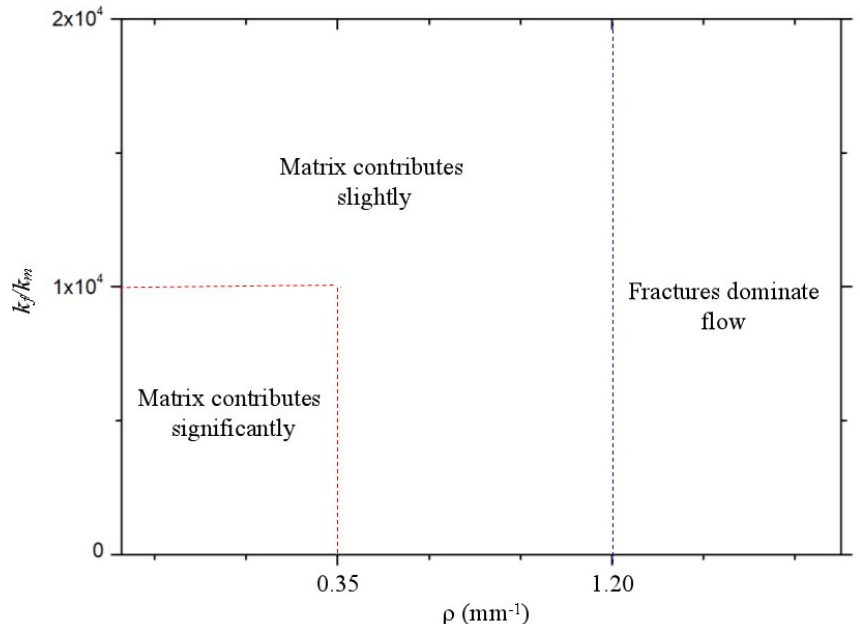
Figure 14. Two-dimensional fluid flow partitioning between the fractures and matrix of fractured rocks with various fracture densities ( w av = 0.284 mm). Three flow regimes were classified to demonstrate fracture–matrix flow partitioning using the permeability ratio k f // k m and fracture density ρ . (i) The matrix significantly contributes to the flow: k f // k m < 1 × 10 − 4 and ρ ≤ 0.35 mm − 1 ; (ii) the matrix contributes slightly to the flow: 0.35 mm − 1 < ρ ≤ 1.2 mm − 1 ; (iii) ρ > 1.2 mm − 1 : fractures dominate the flow.